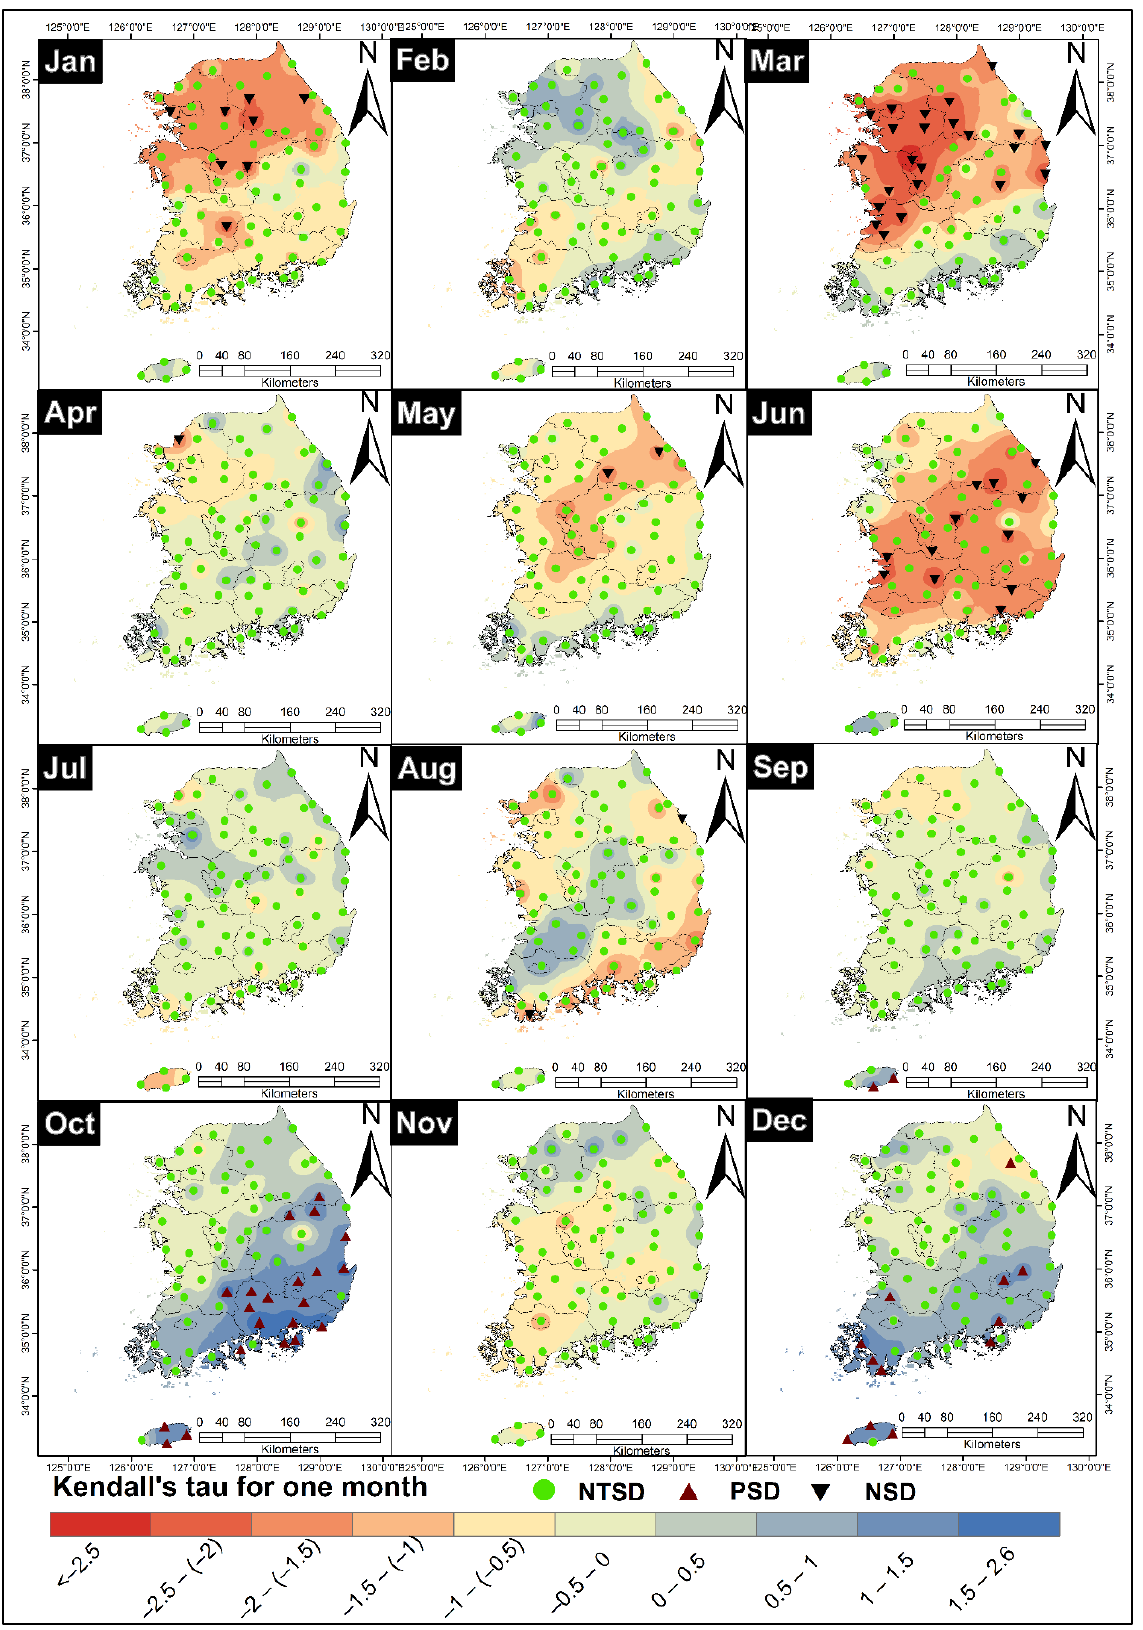
Figure 7. Spatial distribution of Kendall’s tau for one-month SPEI series with 95% significance. Not significantly different (NTSD), positive significant difference (PSD), and negative significant difference (NSD) .